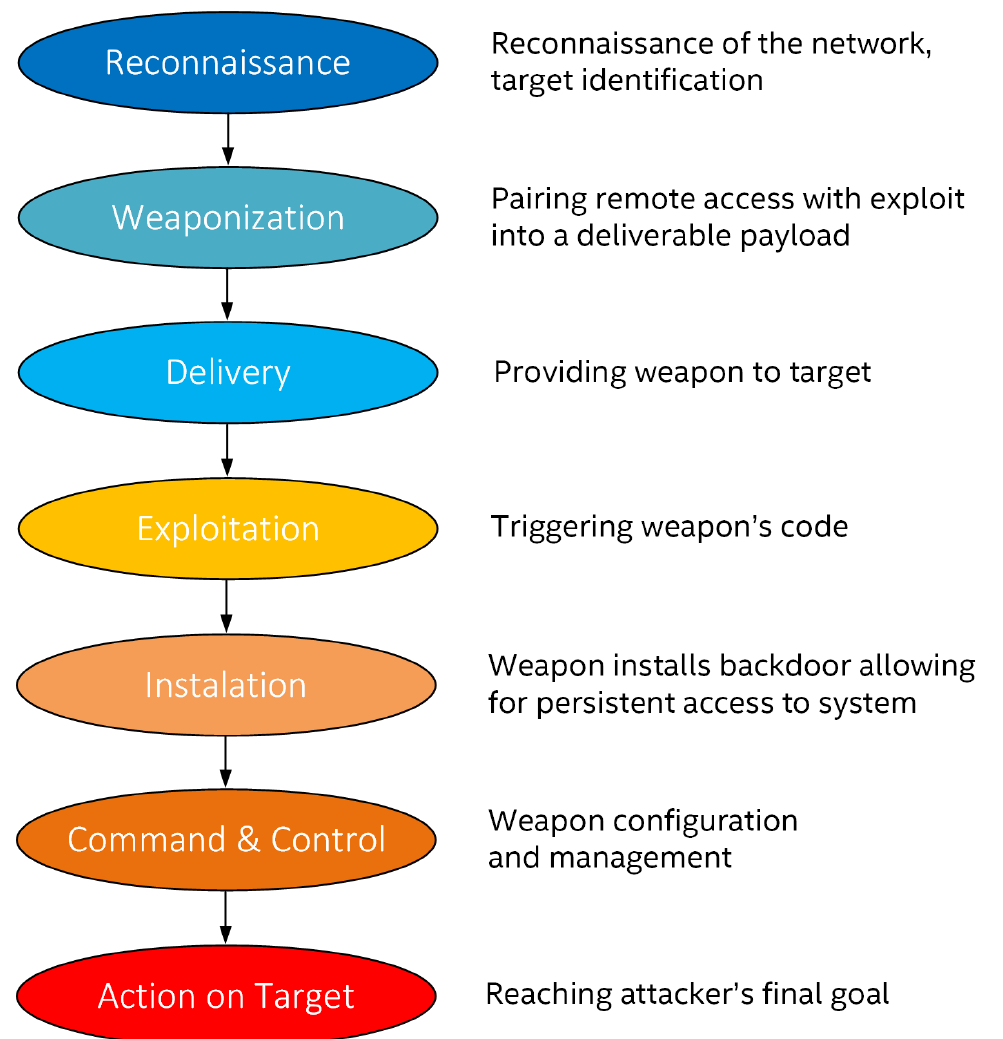
Figure 1. Intrusion Kill Chain Model proposed by Lockheed Martin Corporation